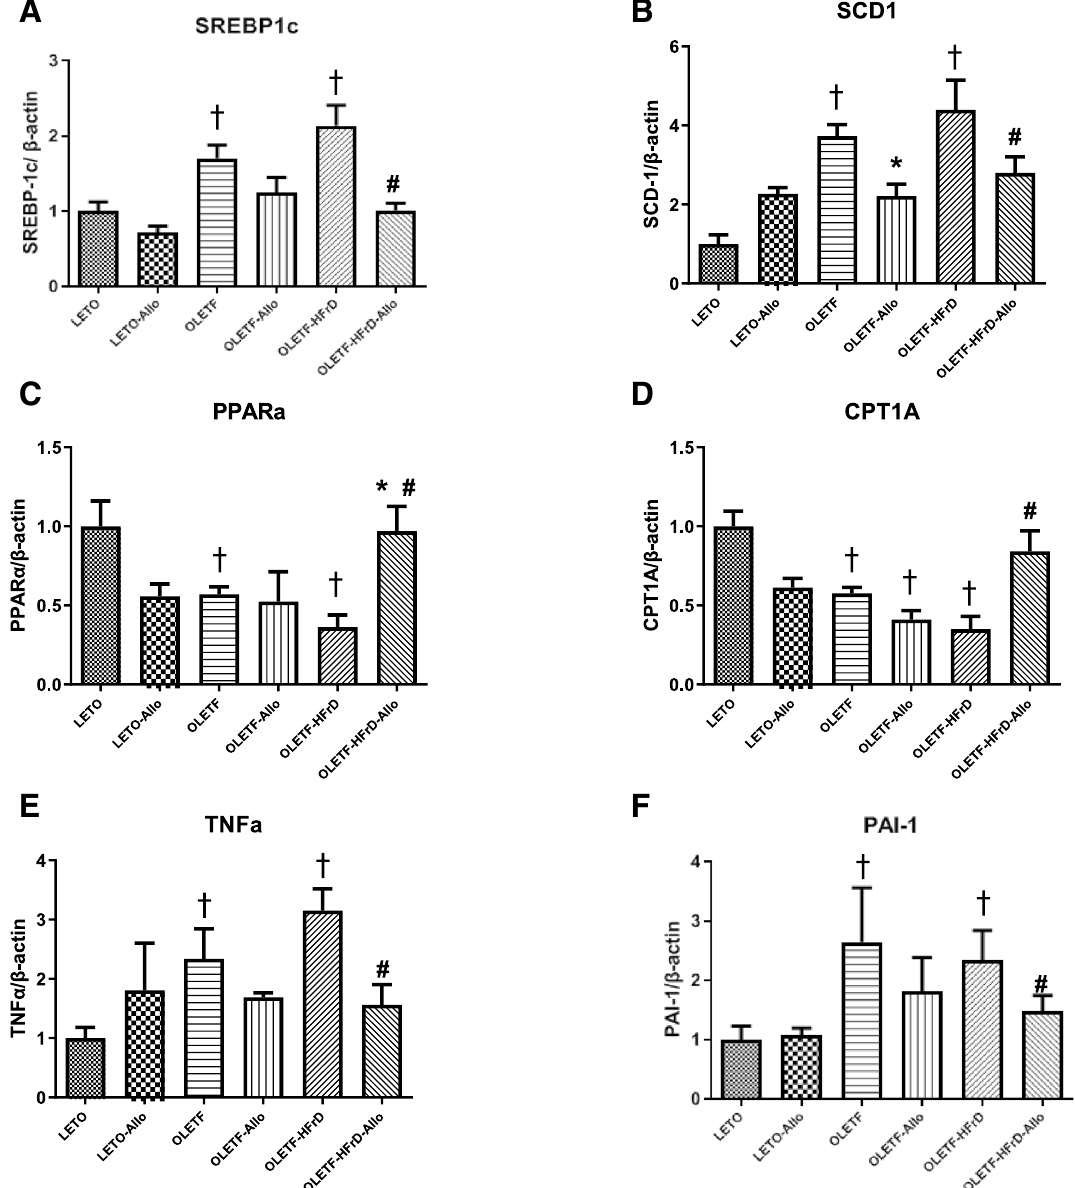
Figure 3. Hepatic mRNA expression of lipid metabolism genes and pro-inflammatory cytokine genes. Hepatic expression of genes was evaluated using real-time PCR. ( A and B ): Lipogenic genes expressions (SREBP-1c and SCD-1) were significantly upregulated in the OLETF and OLETF-HFrD groups compared to LETO group and significantly downregulated in the OLETF-HFrD-Allo group compared to the OLETF-HFrD group. ( C and D ): The expressions of lipid oxidation genes (PPARα and CPT-1) were significantly suppressed in the OLETF and OLETF-HFrD groups compared to the LETO group. However, allopurinol-treatment (OLETF-HFrD-Allo group) ameliorated the downregulation of lipid oxidation genes observed in OLETF-HFrD group. ( E and F ): Proinflammatory cytokine genes (TNF-α and PAI-1) significantly increased in the OLETF and OLETF-HFrD groups, and this increase was abolished in the OLETF-HFrD-Allo group. Data are expressed as mean ± SE. † P < 0.05 versus LETO group, * P < 0.05 versus OLETF group, # P < 0.05 versus OLETF-HFrD group LETO, Long-Evans Tohushima Otsuka; LETO-Allo, LETO rats treated with allopurinol; OLETF, Otsuka Long-Evans Tokushima Fatty rats; OLETF-Allo, OLETF rats treated with allopurinol; OLETF-HFrD, OLETF rats fed with high fructose diet; OLETF-HFrD-Allo rats, OLETF rats fed with high fructose diet which were treated with allopurinol; SREBP-1c, sterol regulatory element-binding protein 1c; SCD-1, stearoyl-CoA desaturase 1; PPARα, peroxisome proliferator-activated receptor-alpha; CPT-1, carnitine palmitoyltransferase 1; TNF-α, tumor necrosis factor-alpha; PAI-1, plasminogen activator inhibitor